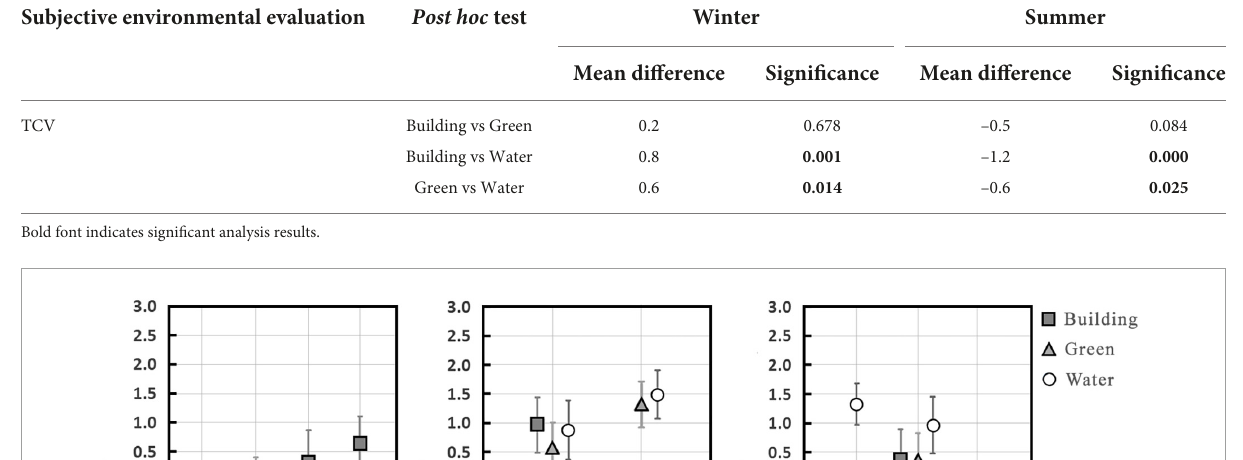
TABLE 6 Post hoc test of the difference between thermal comfort vote (TCV) and landscapes.